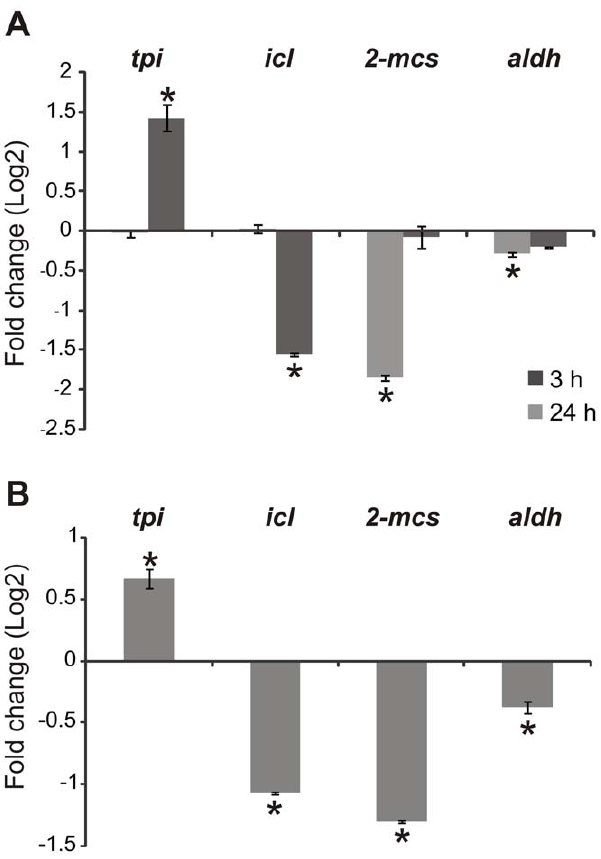
Figure 7. P.brasiliensis transcripts of yeast cells isolated from infected mice correspond to P.brasiliensis proteins differen- tially regulated under iron limiting conditions. P. brasiliensis transcript levels of genes encoding enzymes involved in energy processes; triosephosphate isomerase ( tpi ), isocitrate lyase ( icl ), 2- methylcitrate synthase ( 2-mcs ) and aldehyde dehydrogenase ( aldh ), isolated from yeast cells following iron starvation (A), and from yeast cells recovered from the spleens of infected BALB/c mice (B). Transcript levels were measured using quantitative RT-PCR. Data were normalized to the L34 protein transcript and presented as log2 (fold change). Student’s t test was used for statistical comparisons. Error bars represent standard deviation from three biological replicates while * represents p # 0.05.